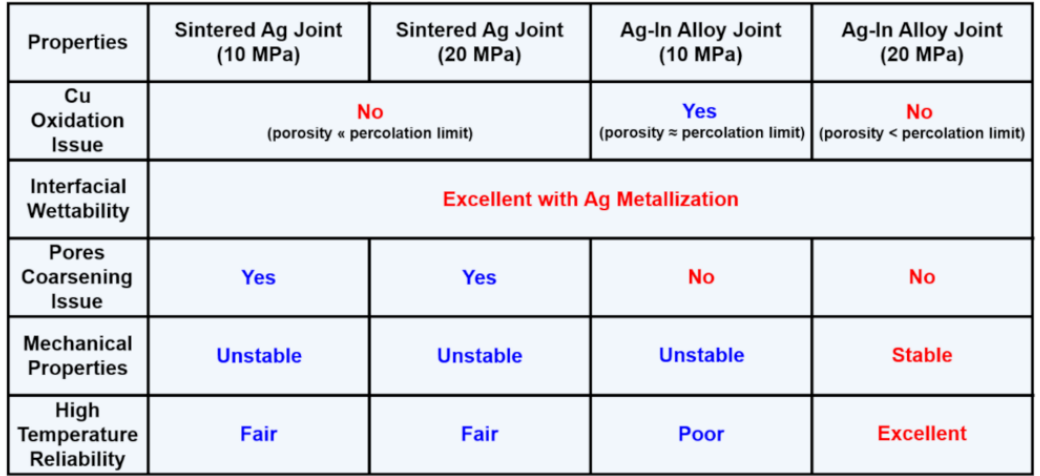
Figure 17. Graphical summary of the benefits of robust Ag–In alloy joints bonded with 20 MPa compared to other joints in 300 ◦ C high-temperature